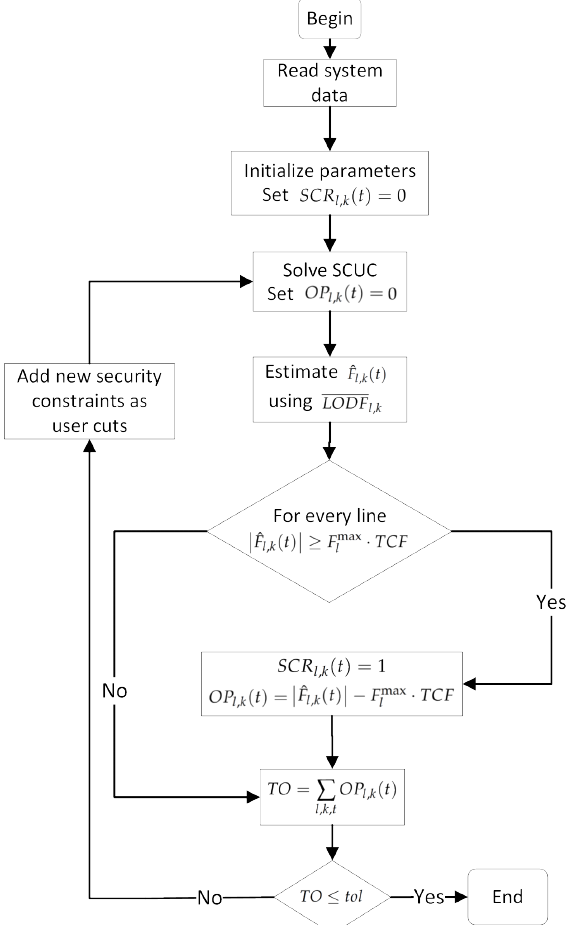
Figure 2. Flowchart of the algorithm for adding security constraints as user